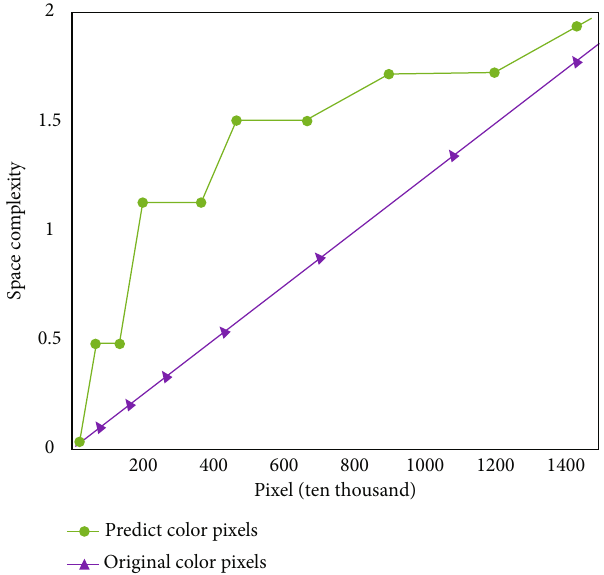
Figure 8: The spatial complexity of the original color matching pixels of digital artwork and the resulting pixels after